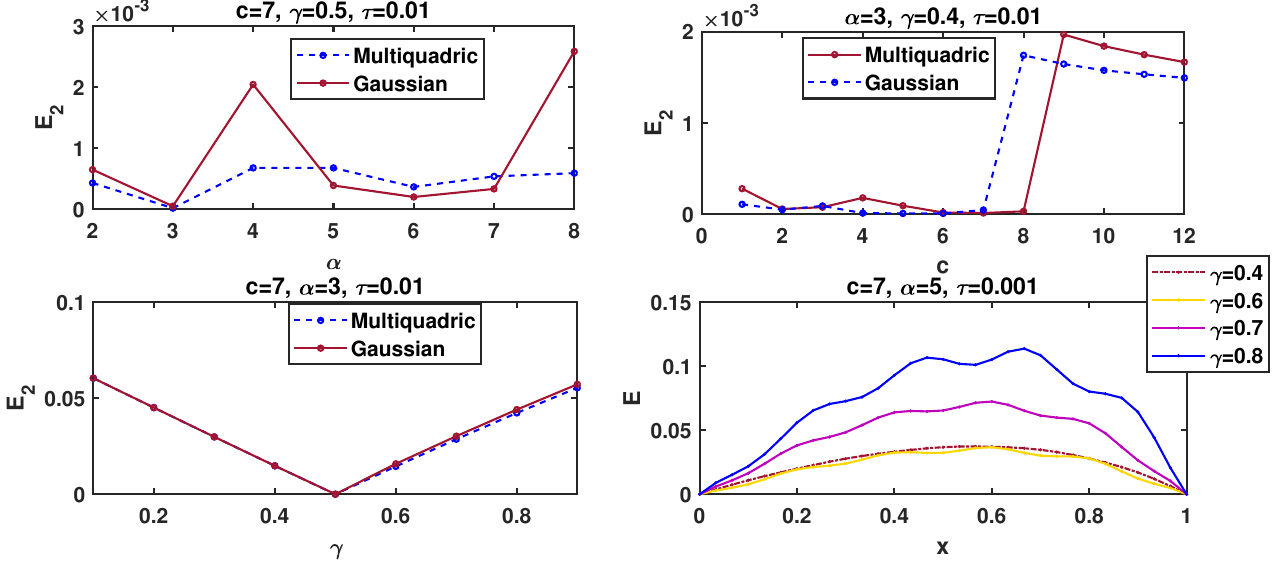
Figure 12. Comparison errors with respect to α , c , and γ at time T = 1 for Example 4, where ν = 1, K = 100, M = 47, and N =